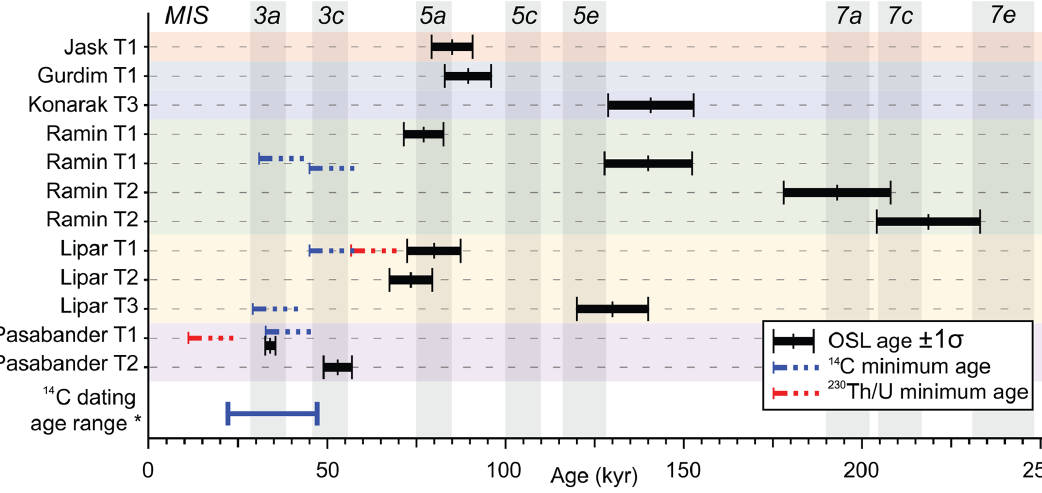
Figure 9. Comparison of age results for the different Makran marine terraces. Gray vertical bands: age extent of the different sea-level highstands (Table B.2 in Supplement S2). For the list of previous 14 C dating in the Iranian Makran, see Table A in Supplement S1.